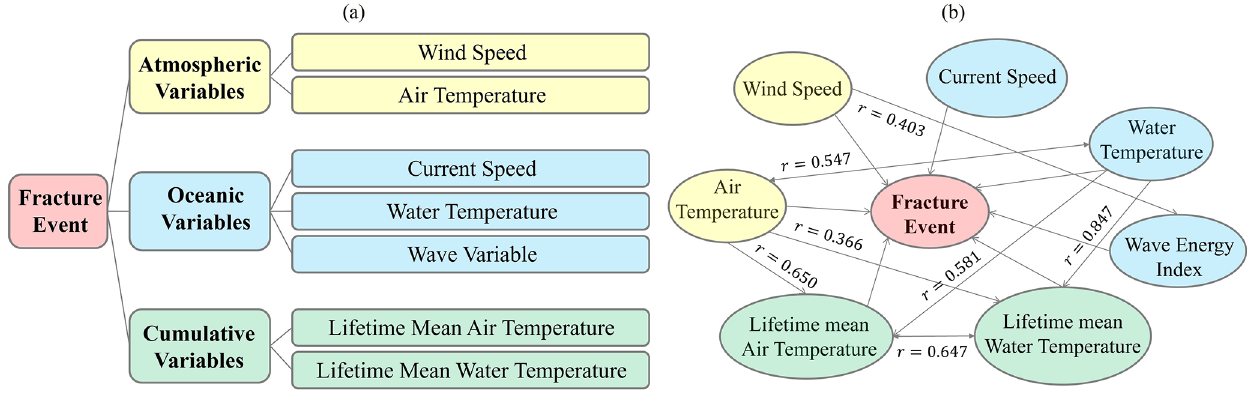
Figure 1. The classification of variables for the Bayesian fracture network (a) and the associated directed acyclic graph that shows the inter-relationship between the variables, with the arrowheads showing the causality and the r values showing the associated correlation coefficients (b)